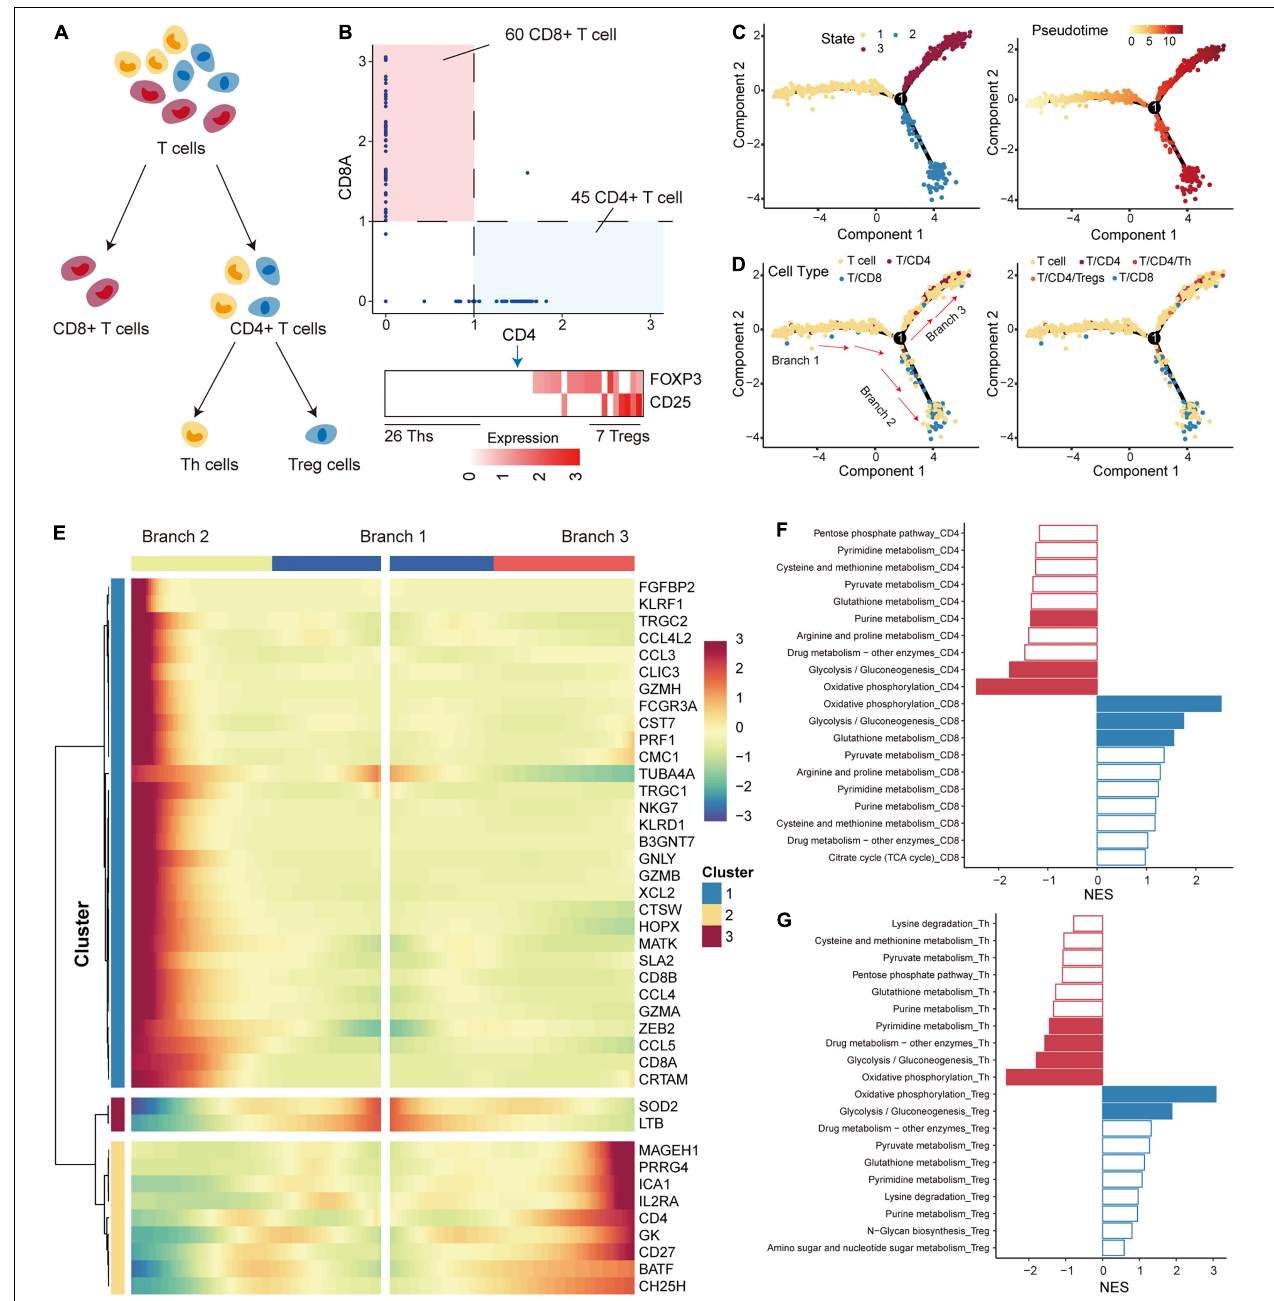
FIGURE 3 | Differentiation trajectory and metabolic features of T cells. (A) The panel shows the differentiation process of T cells; T cells were divided into CD4+ T, CD8+ T, Th, and Treg cells. (B) Expression levels of marker genes (including CD4, CD8A, FOXP3, and CD25) were used to separate T-cell subtypes in non-small cell lung cancer (NSCLC). (C) The pseudo-time trajectory of T-cell differentiation. Each point represents a cell and is marked with the cell state (left) and pseudo-time (right). (D) Same as in (C) but for cells marked with T-cell subtypes. (E) The heatmap shows the branch-dependent genes at branch point 1. The center of the heatmap is branch B1, the left is B2, and the right is B3. (F) Top 10 metabolic pathways enriched in CD4+ or CD8+ T cells. Significantly enriched pathways with gene set enrichment analysis (GSEA) p -values < 0.05 are highlighted in red (CD4) or blue (CD8). (G) Top 10 metabolic pathways enriched in Th or Treg cells. Significantly enriched pathways with GSEA p -values < 0.05 are highlighted in red (Th) or blue